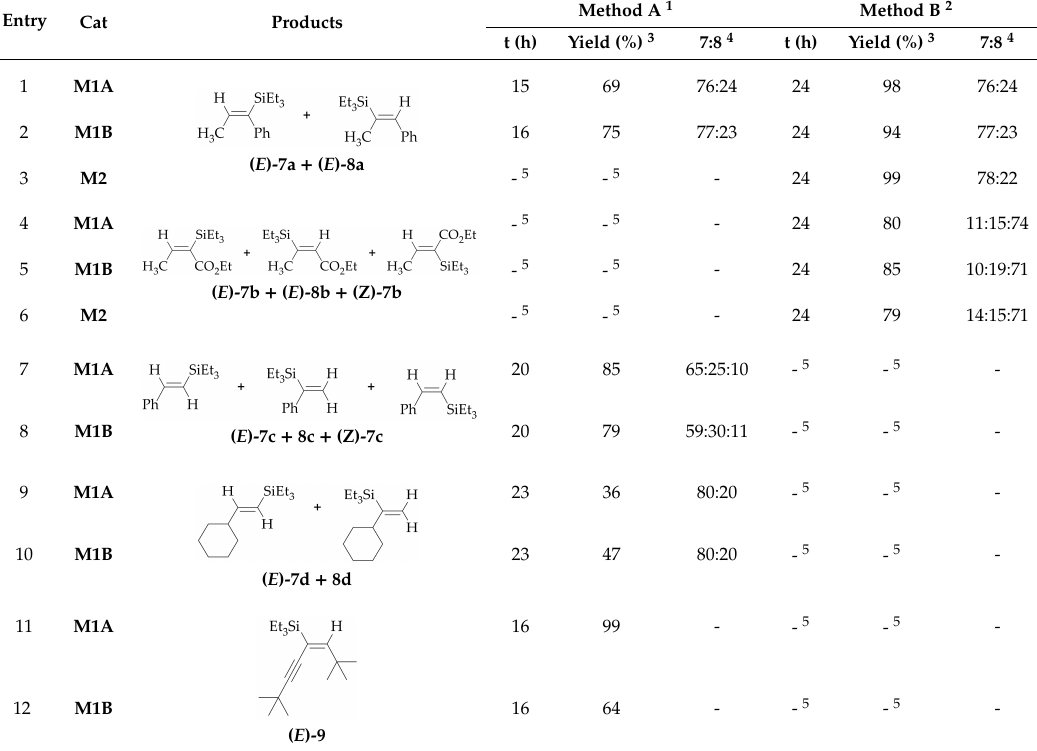
Table 5. Hydrosilylation of di ff erentiated unsymmetric alkynes under catalysis by Rh